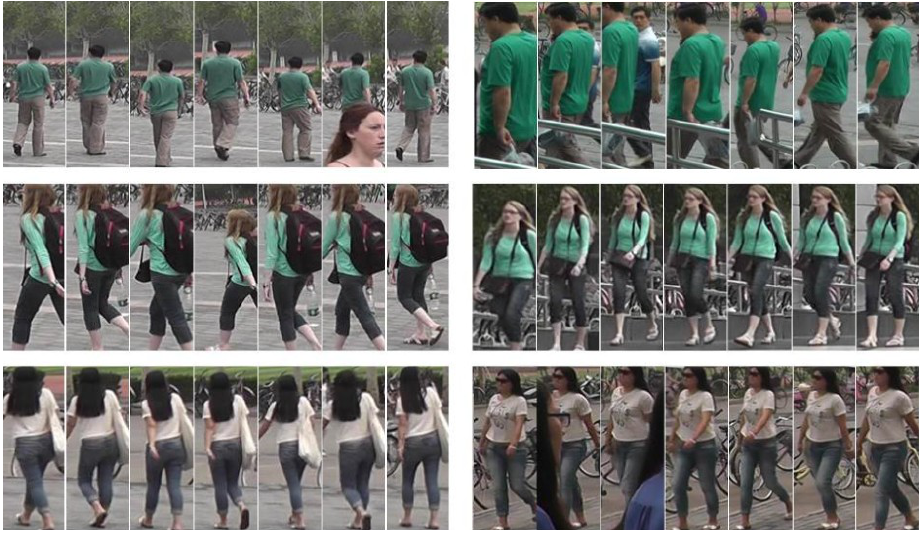
Figure 11. A sample tracklet of MARS. Adapted from [48]. Each row is labeled as the same